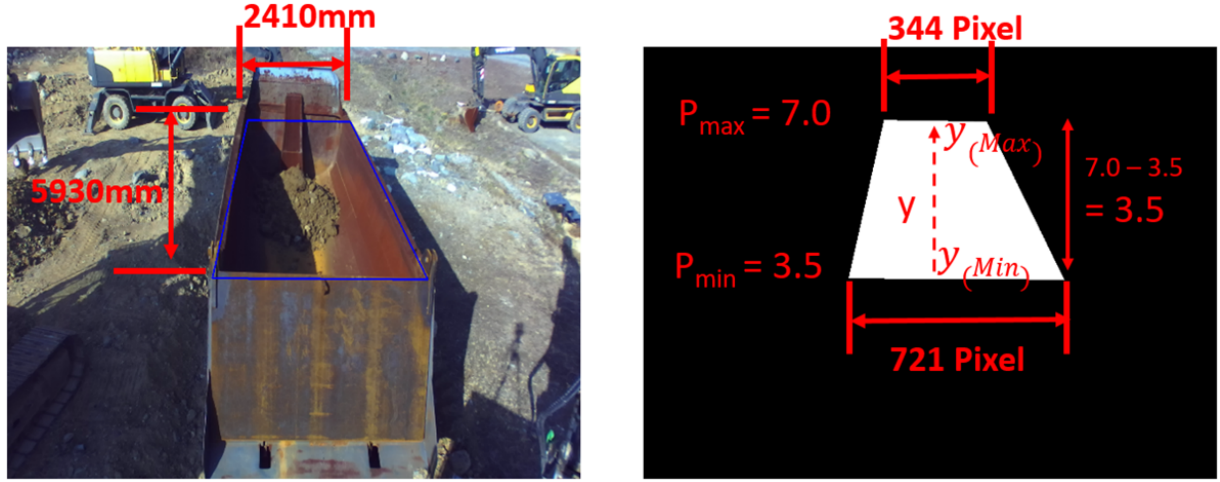
Figure 24. Area detection for the part to measure the internal volume of the loading box in the 2D image.